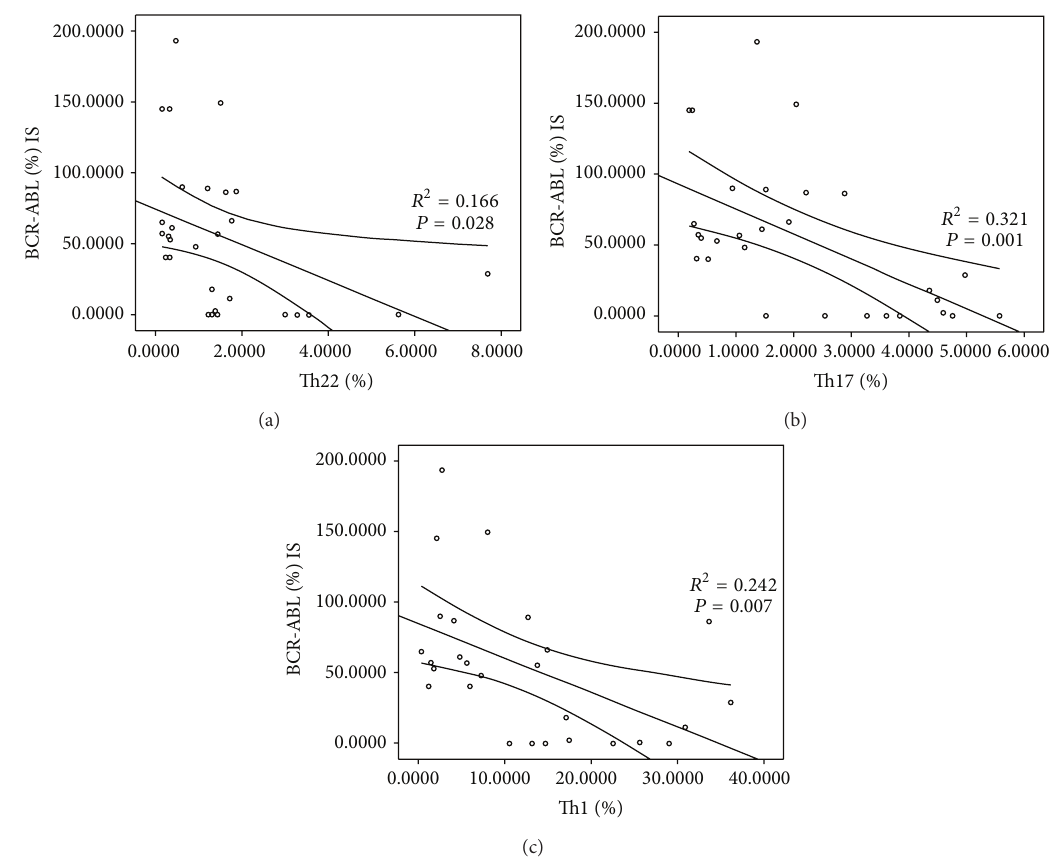
Figure 7: Clinical relevance between the frequencies of Th22, Th17, and Th1 cells and BCR-ABL (%) IS in CML patients. (a) Negative correlation was found in Th22 cell and BCR-ABL (%) IS. (b) Negative correlation was found in Th17 cell and BCR-ABL (%) IS. (c) Negative correlation was found in Th1 cell and BCR-ABL (%)